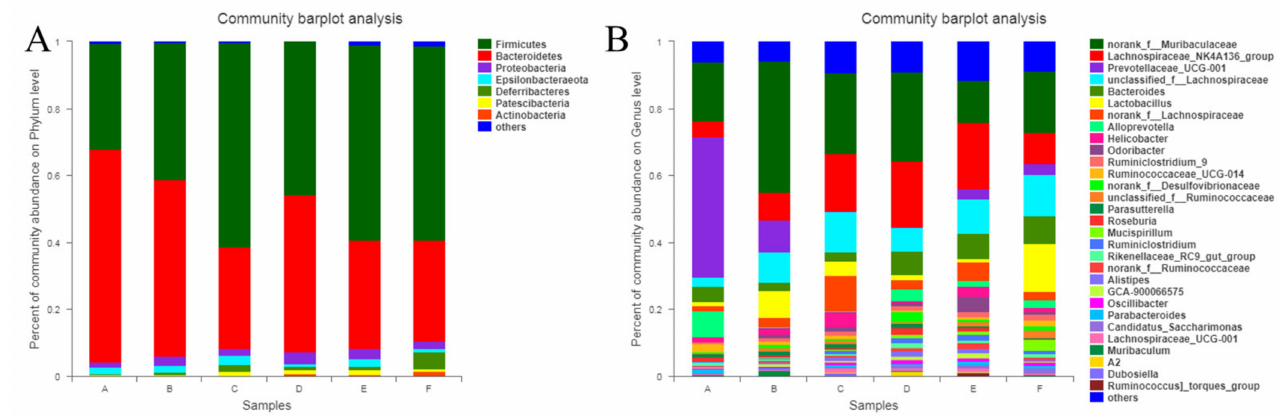
Figure 9. Histogram of the relative abundance of microflora communities at phylum ( A ) and genus ( B )